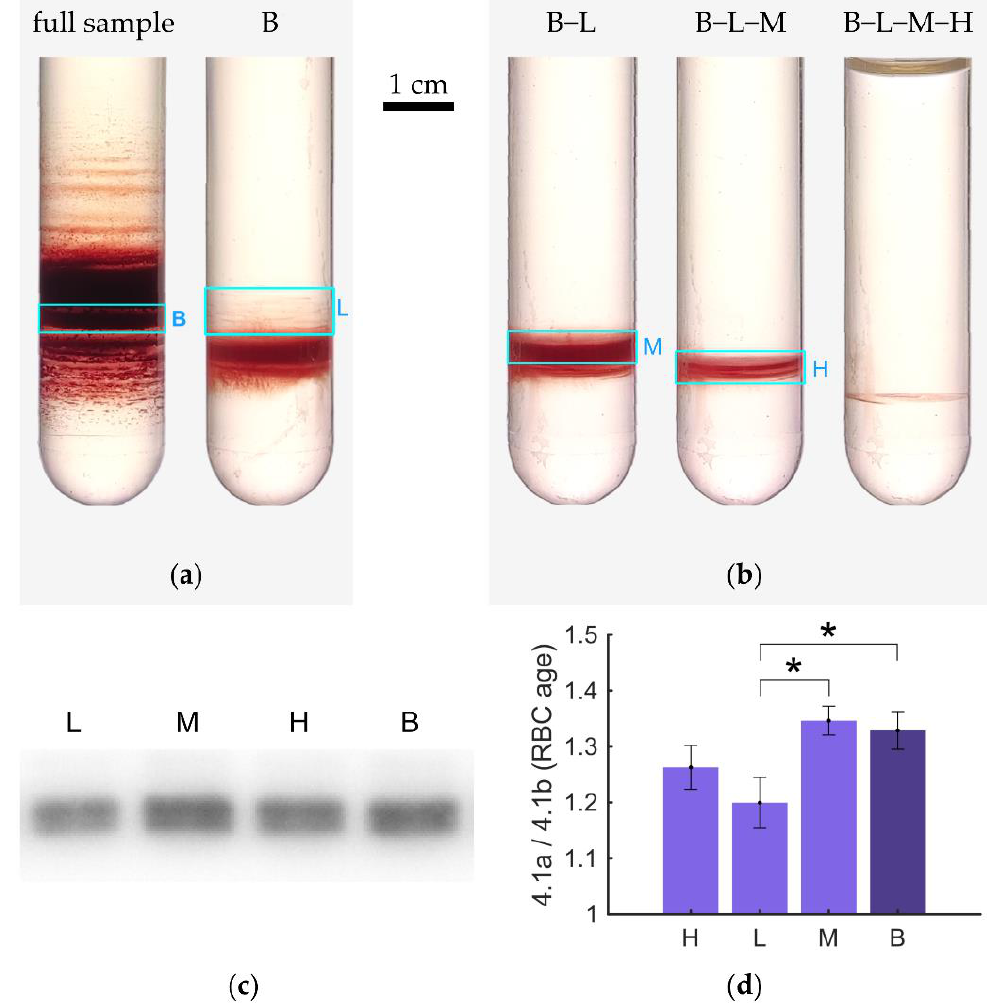
Figure 4. Western blotting after redistribution of an extracted band. Panel ( a ) shows the distribution of a full blood sample from heparin tubes after centrifugation in an isotonic medium. A band (B) was extracted and redistributed in an equivalent gradient. ( b ) From the recentrifuged tube, a low (L), a medium (M), and a high (H) density layer were extracted successively. Panel ( c ) shows an excerpt of a western blot. RBCs were treated with the sample buffer as cell suspensions at 20% Ht, and 10 μL of each sample were loaded in the gels. In ( d ), bar graphs of the mean 4.1a to 4.1b ratio derived from six samples for each band, randomly distributed over four different gels, error bars show the SEM; a single star indicates 𝑝 < 0.05 .